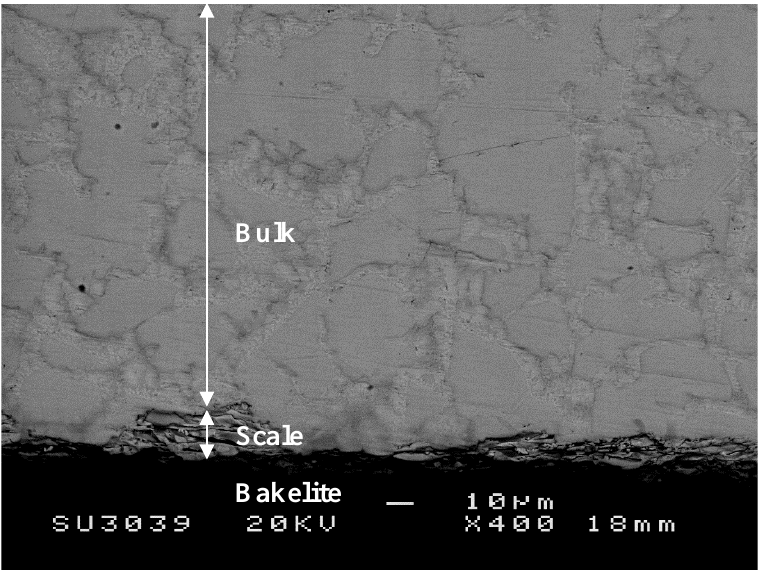
Figure 8. BSE image showing typical microstructures of a cross-section of the alloy ZF6 after oxidation in air at 800 °C for 100 h.